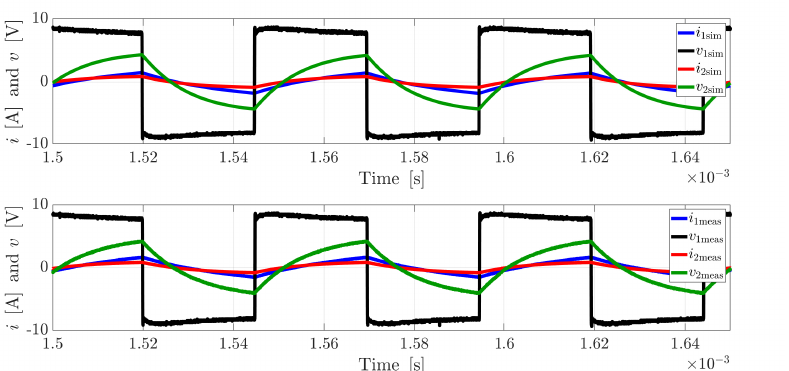
Figure 14. Comparison between the measured and simulated voltages and currents in Simulink ® . In this picture, the device is supplied with a 20kHz waveform. RMS values for i 1 , i 2 and v 2 are reported in Table